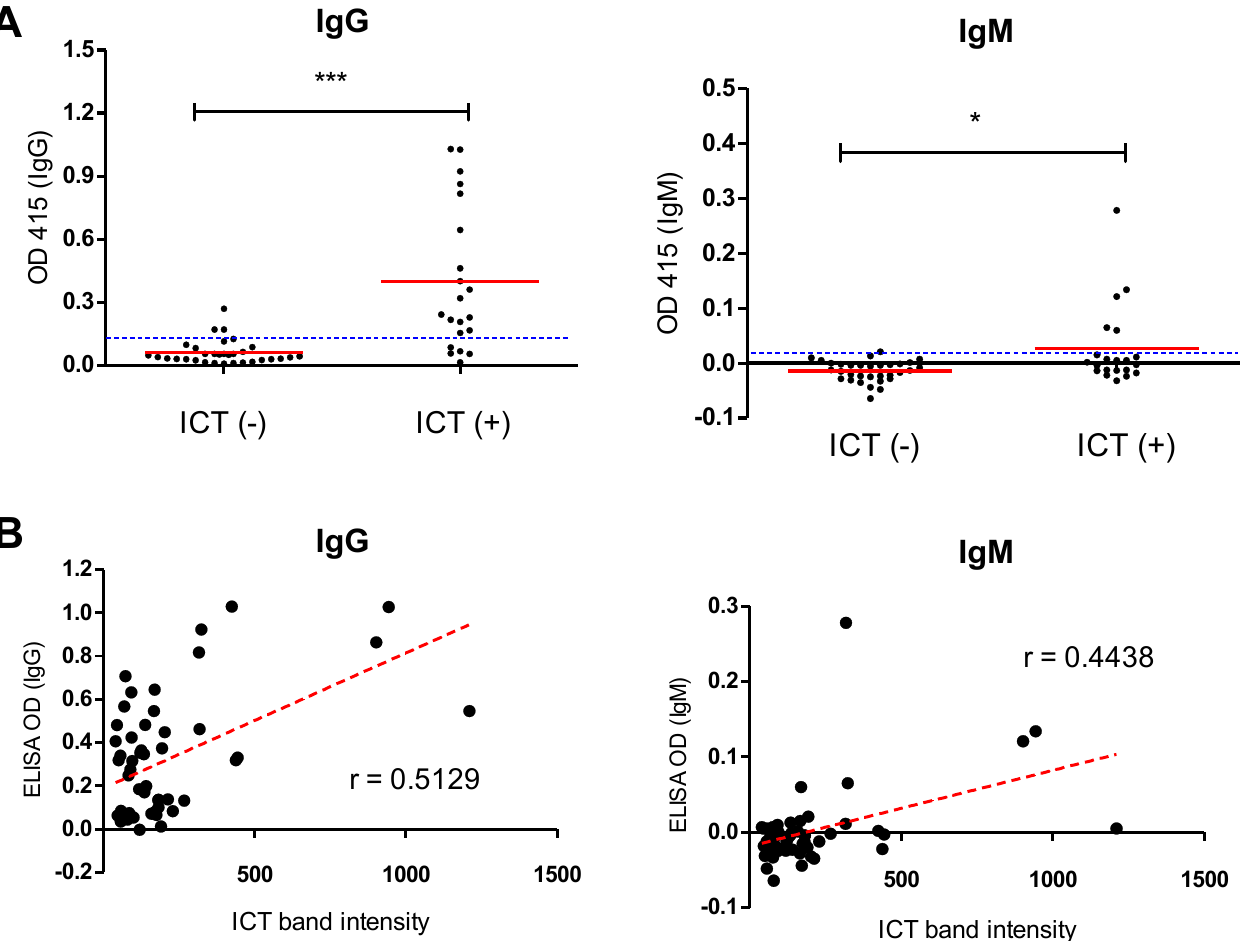
Figure 7. Application of the NcSAG1-based immunochromatographic test (ICT) against the enzyme-linked immunosorbent assay (ELISA) using sera from field cattle. Serum samples ( n = 53) collected from a cattle farm were tested using ICTs for different antigens (NcSAG1, NcGRA7, NcGRA6, and NLA) and compared against IgG- and IgM-ELISAs of relevant antigens. ( A ) Comparison of the NcSAG1-based ICT and ELISA for detection of N. caninum -specific antibodies in field cattle. Dotted blue horizontal lines represent ELISA cutoff values. ELISA results were considered positive at an OD415 > 0.132 for NcSAG1 IgG-ELISA, and >0.020 for NcSAG1 IgM-ELISA. * p < 0.05, *** p < 0.0001, Mann–Whitney test. ( B ) Pearson’s correlation coefficient of the ICT results against different antibodies and ELISA OD values of field cattle sera. Scatter graphs show the correlation between relative band intensity in the ICT and absorbance values in the ELISA. Correlation coefficients were calculated using Pearson’s correlation coefficient: |r| = 0.70, strong correlation; 0.5 < |r| < 0.7, moderately strong correlation; and |r| = 0.3–0.5 weak-to-moderate correlation. NcSAG1, correlation coefficient (r): r = 0.5129 for IgG-ELISA, and r = 0.4438 for IgM-ELISA.